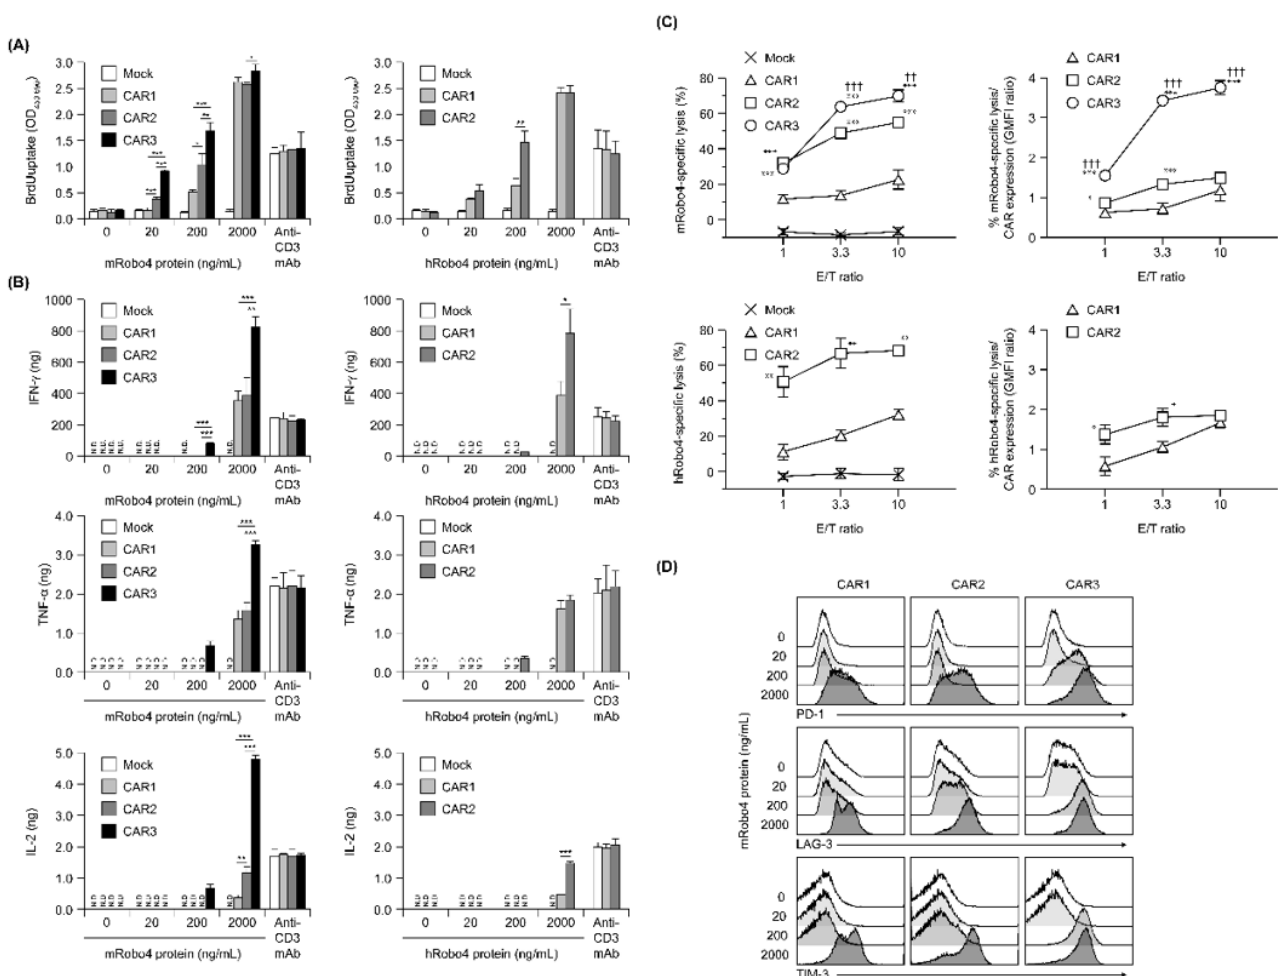
Figure 3. In vitro functional assays of anti-Robo4 CARs with different ARDs. ( A ) Proliferation after stimulation with mouse (left) or human (right) Robo4 protein, measured via BrdU uptake ELISA. Statistical analysis was performed using Tukey’s test for mRobo4 and Welch’s t -test for hRobo4; * p < 0.05, ** p < 0.01, *** p < 0.001. N.D., not detected. ( B ) Cytokine production following stimulation with mouse or human Robo4 protein. IFN- γ , TNF- α , or IL-2 were measured using ELISA. Left panels—stimulated with mRobo4; right panels—stimulated with hRobo4; Statistical analysis was performed using Tukey’s test and Welch’s t -test, respectively: * p < 0.05, ** p < 0.01, *** p < 0.001. ( C ) CAR-T cells 3 days after retroviral transduction were cultured with L1.2 cells and m/hRobo4-expressing L1.2 cells at the indicated E/T ratios for 18 h. Numbers of L1.2 cells and m/hRobo4 + L1.2 cells in the wells were measured using FCM. Specific cytotoxicity against m/hRobo4 + L1.2 cells was calculated from the ratio of m/hRobo4 + L1.2 cells to L1.2 cells. Right panels show specific cytotoxicity against CAR expression (GMFI ratios). Data are presented as mean ± SD of a triplicate. Statistical analysis was performed using Tukey’s test for mRobo4 (* p < 0.05, *** p < 0.001 versus CAR1, †† p < 0.01, ††† p < 0.001 versus CAR2) and Welch’s t -test for hRobo4 (* p < 0.05, ** p < 0.01, *** p < 0.001 versus CAR1). ( D ) Expression of the exhaustion markers PD-1, LAG-3, and TIM-3 on CAR-T cells measured using FCM after 24 h stimulation with mRobo4 protein at 20–2000 ng/mL. Cells were pregated live and CD3 + cells.